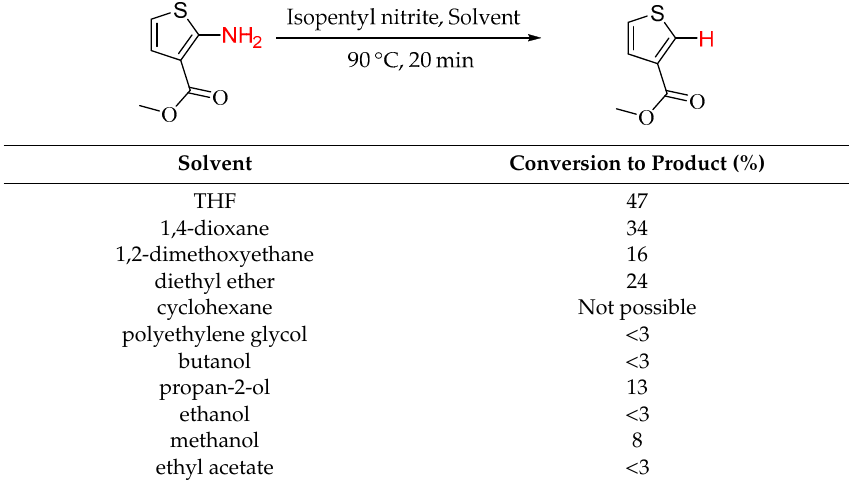
Table 2. Conversion of methyl 2-aminothiazole-5-carboxylate ( 1a ) to methyl thiazole-5-carboxylate ( 2a ) at various temperatures in THF.